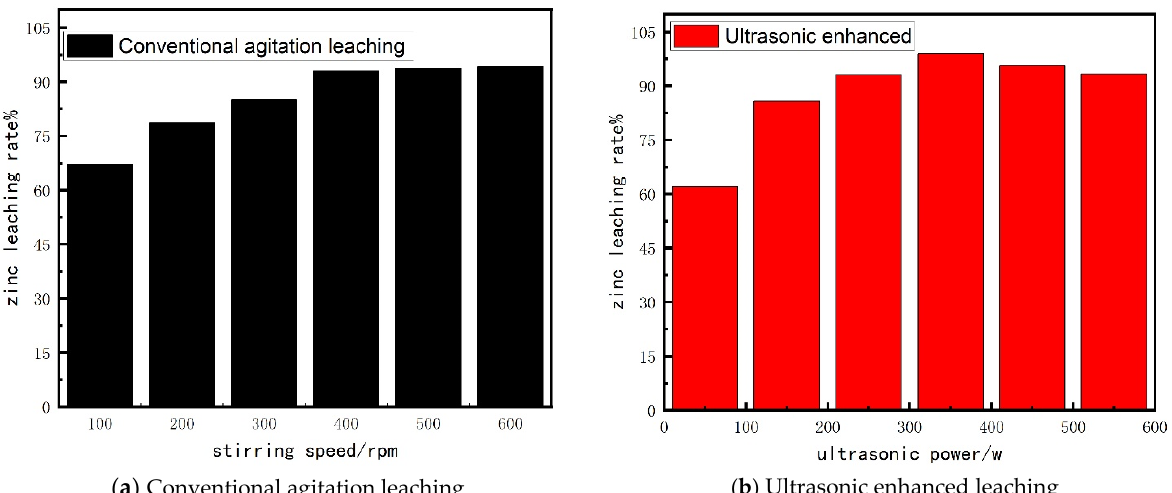
Figure 11. Effect of stirring speed and ultrasonic power on the zinc leaching rate ( a ) conventional: leaching temperature = 90 °C, leaching time = 480 min, liquid ‐ solid ratio = 16:1; ( b ) ultrasonic: leaching temperature = 60 °C, leaching time = 240 min, liquid ‐ solid ratio = 12:1.